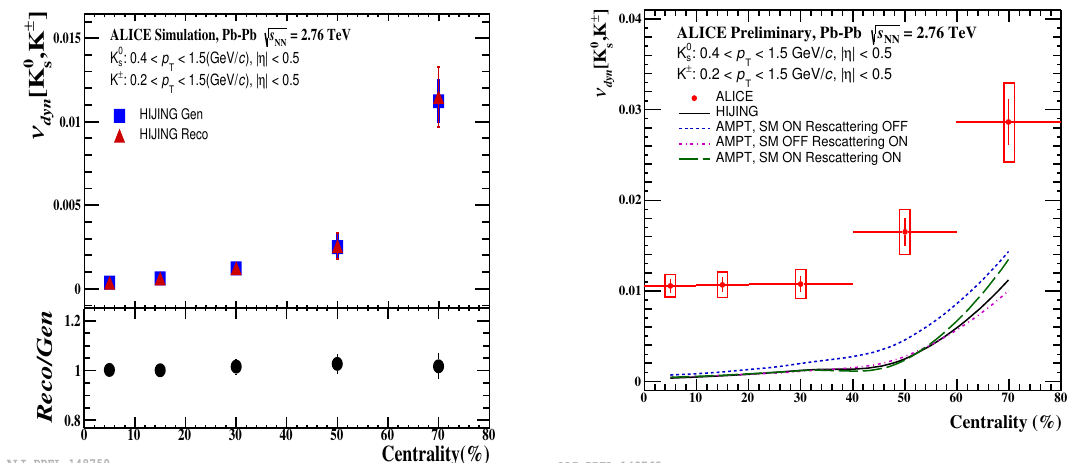
Figure 2. Left: ( a ) ν dyn vs centrality for HIJING model calculations for K 0 s K ± . Right: ( b ) ν dyn vs centrality for ALICE data, HIJING and AMPT model calculations for K 0 s K ±